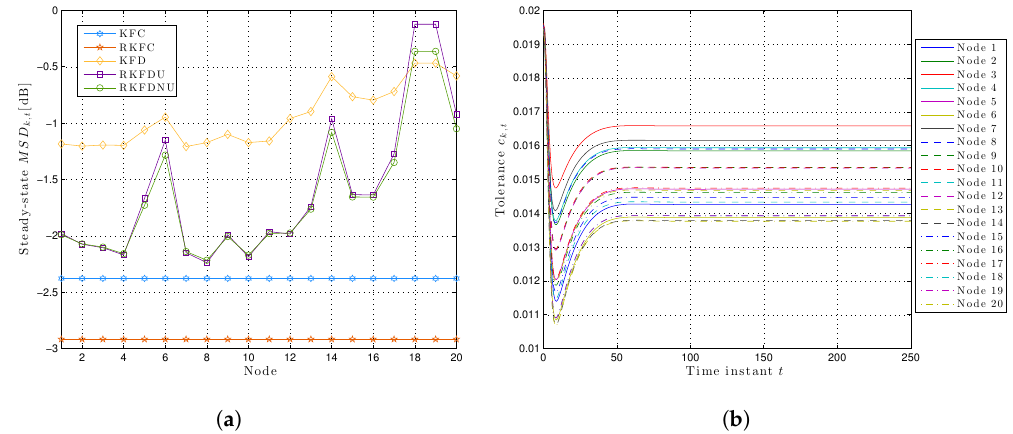
Figure 3. ( a ) Least favorable mean square deviation for each node in the steady-state with tolerance c = 0.02. ( b ) Time-variant local tolerances for each node over time with c =